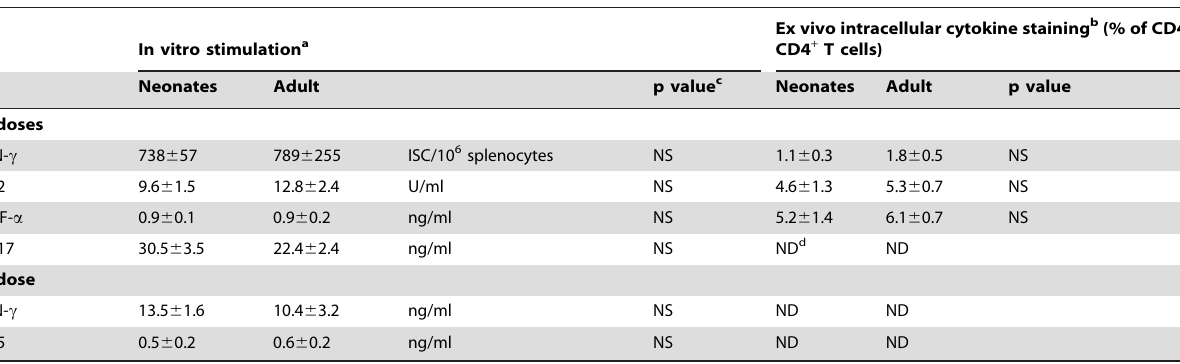
Table 1. Ag85B-ESAT-6-specific T cell responses following neonatal and adult immunization with Ag85B-ESAT-6 in the CAF01 adjuvant.